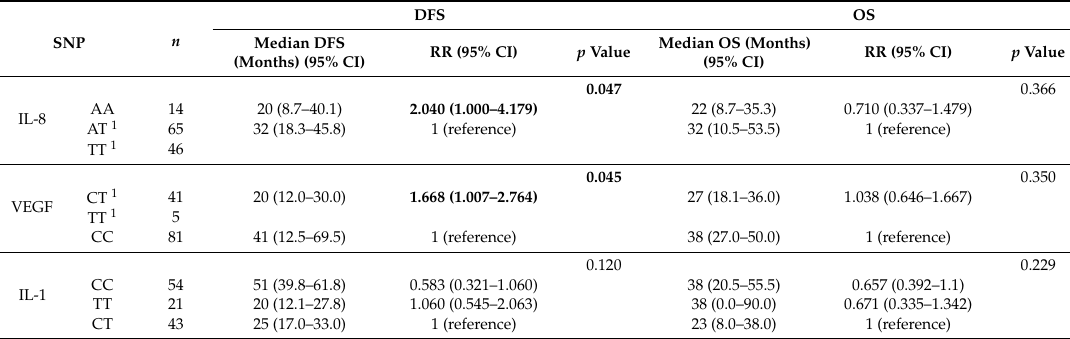
Figure 1. ( a ) Disease-free survival in the carriers of the interleukin-8 T-251A polymorphism, ( b ) the vascular endothelial growth factor C + 936T (VEGF) polymorphism and ( c ) the unfavorable alleles grouped together. Censored cases indicate the time of last follow-up for those patients who had neither recurred nor died at the time of the analysis of data. Table 4. Polymorphisms of genes analyzed and disease-free survival (DFS) as well as overall survival in patients with hepatocellular